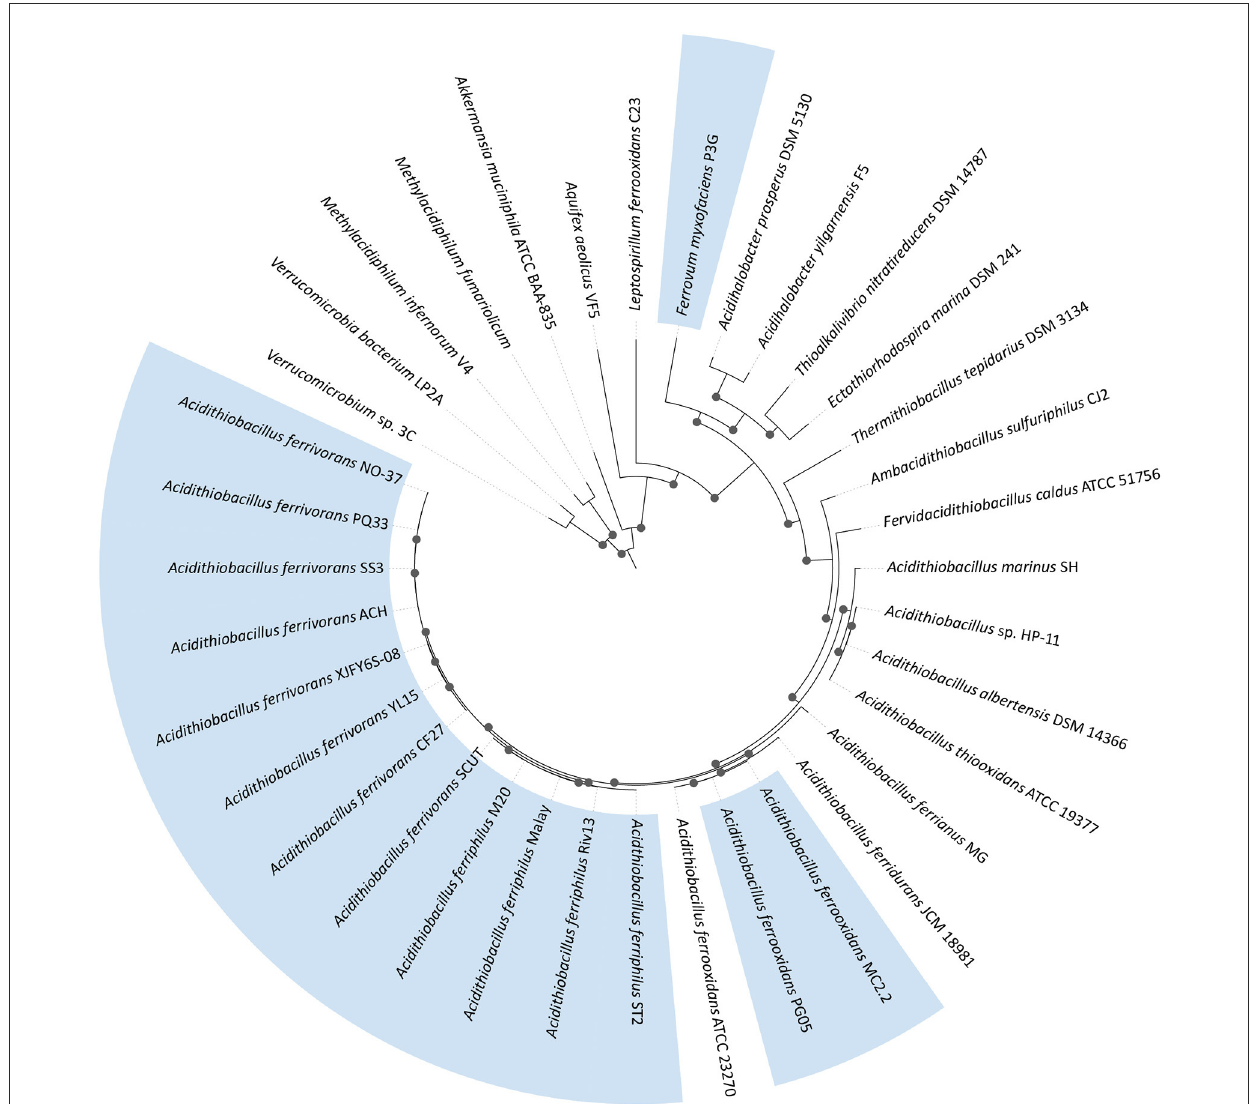
FIGURE2 Maximum likelihood phylogenetic tree of eurypsychrophilic acidophiles (in blue) plus relatives. The tree was constructed using 31 conserved proteins (Ciccarelli et al., 2006) using 1,000 replicates. Bootstrap values of ≥ 60% are represented by black dots on the nodes. The phylogenomic tree was visualized with iTOL6 (Letunic and Bork,